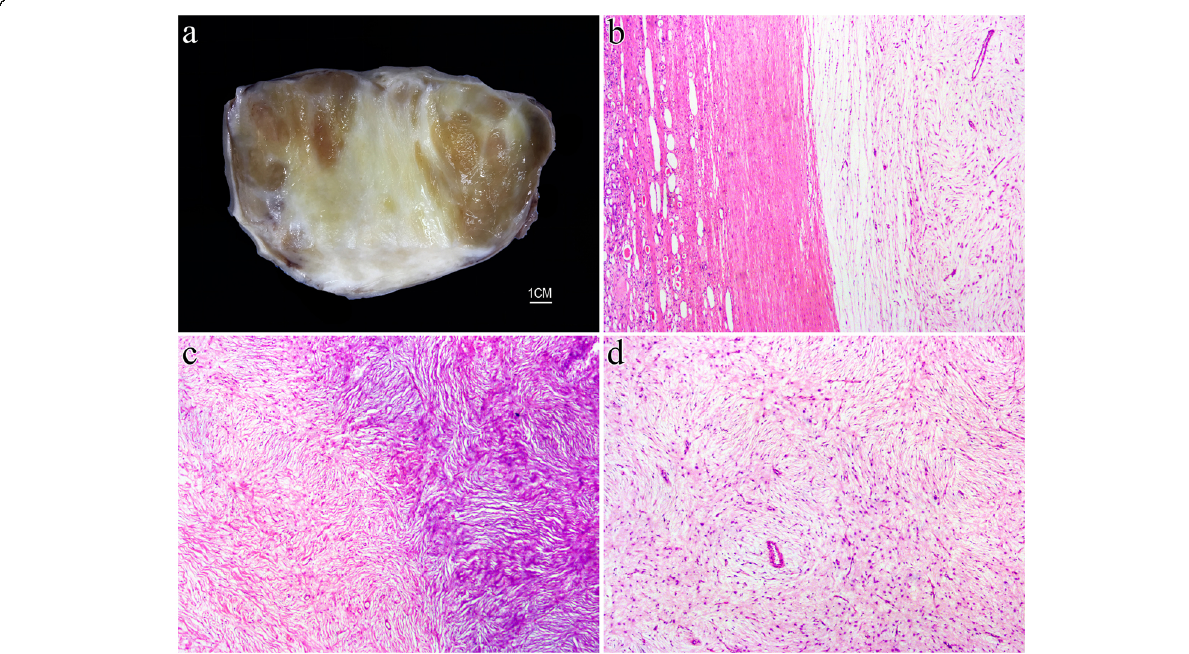
Fig. 5 Case 2. Macroscopic examination showed a well-defined tumor with a clear boundary to the surrounding thin renal tissue that was white to yellowish in color ( A ). The tumor was clearly demarcated from the surrounding renal parenchyma and seemed to originate from the renal capsule ( B ). The tumor showed alternating zones of collagenous and mucinous stroma ( C ) and consisted of spindle cells with elongated bipolar cytoplasmic processes arranged in storiform and whorled patterns ( D )